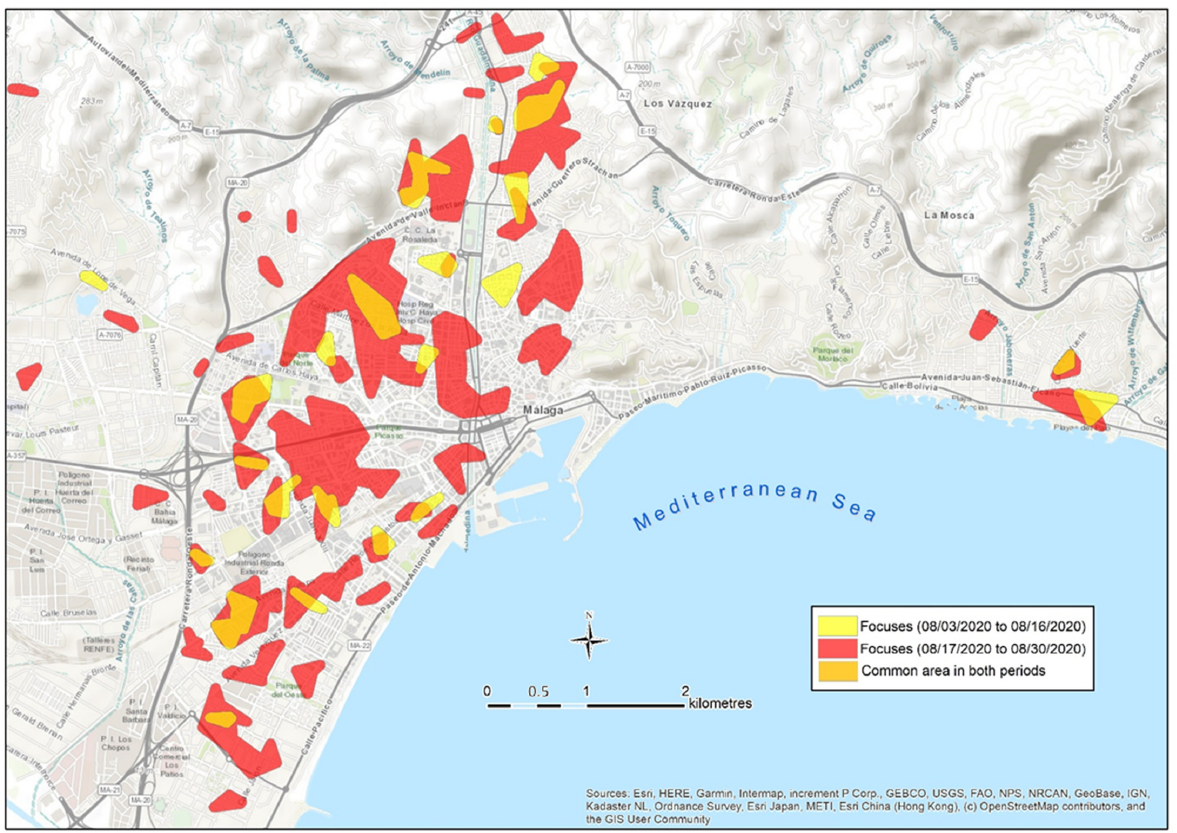
Figure 8. Superposition of the contagion focuses in Málaga in two successive bi-weekly periods during August 2020.